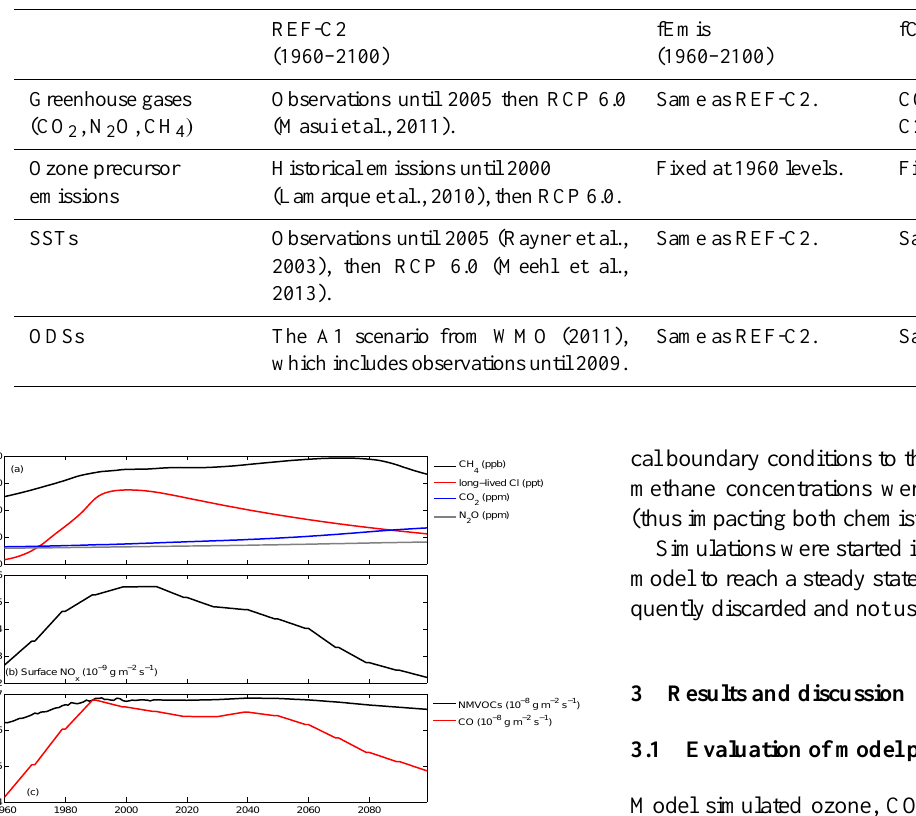
Table 1. Summary of boundary conditions used for the SOCOL CCM simulations.